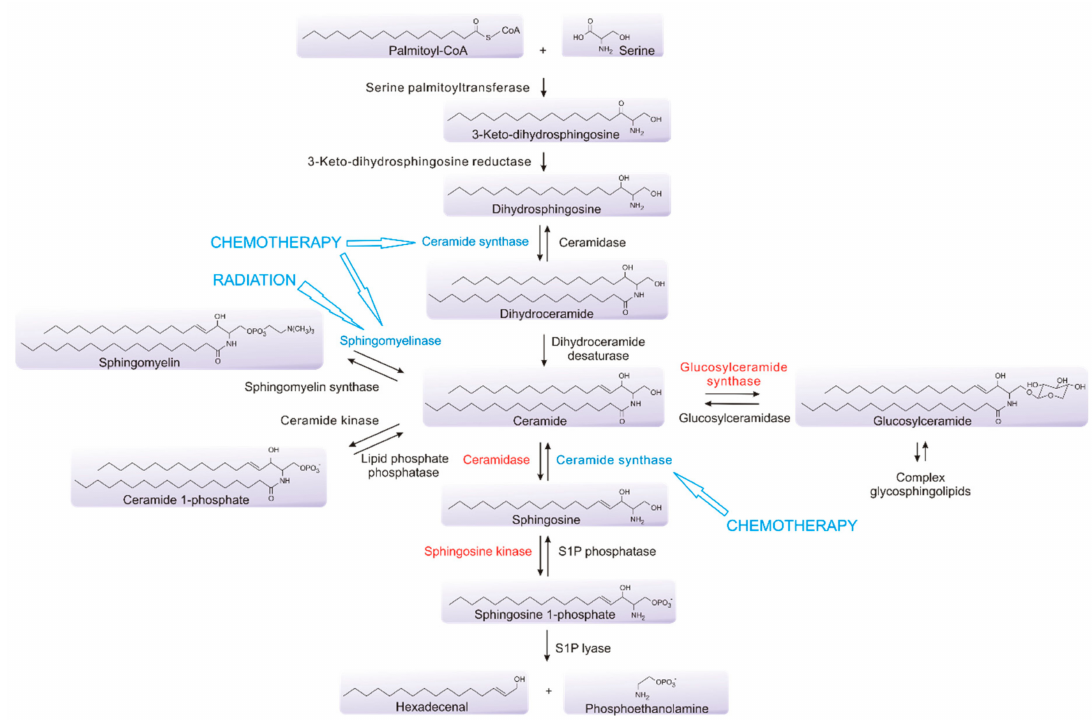
Figure 2. Sphingolipids act as critical bioactive signaling molecules to determine many aspects of cell fate and function. Central to the sphingolipid pathway is ceramide, a key mediator of the apoptotic response of cells to radiation and chemotherapeutic drugs. Ionizing radiation activates acid SMase to induce the conversion of sphingomyelin to ceramide. Chemotherapies including TMZ promote ceramide accumulation through multiple mechanisms, including the activation of ceramide synthases and N-SMase (shown in blue). Enhanced activity of other key enzymes involved in sphingolipid metabolism, including acid ceramidase, sphingosine kinases or glucosylceramide synthase (shown in red), represent mechanisms which GBM cells exploit to overcome existing therapies through reducing therapy-induced ceramide